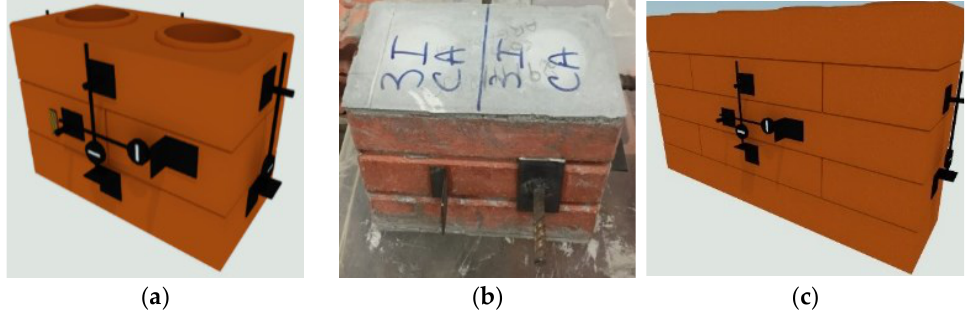
Figure 5. Prisms with indication of shafts for the LVDT: ( a ) prism models; ( b ) clad prism; ( c ) small wall model.